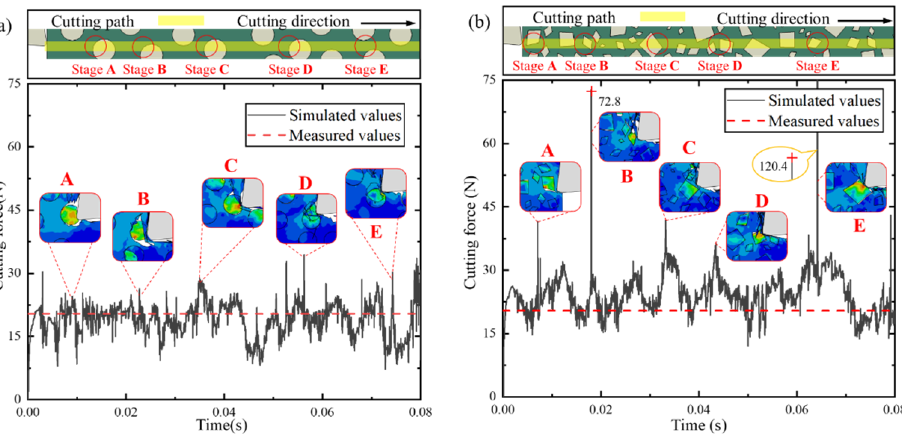
Figure 10. Cutting force variation under a cutting speed of 250 mm/s and a cutting depth of 25 μ m